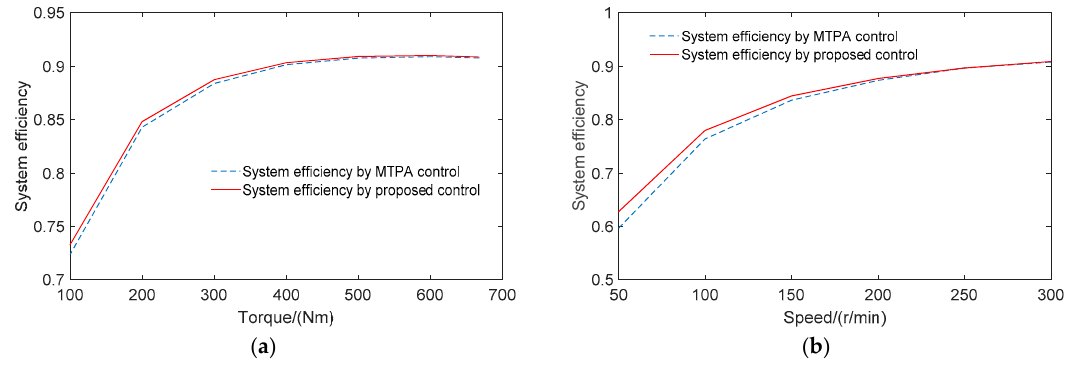
Figure 14. System efficiency of the SiC-MOSFETs-based PMSM direct drive system by the MTPA control and the proposed system efficiency improvement control method. ( a ) System efficiency at rated speed; ( b ) system efficiency at rated torque.